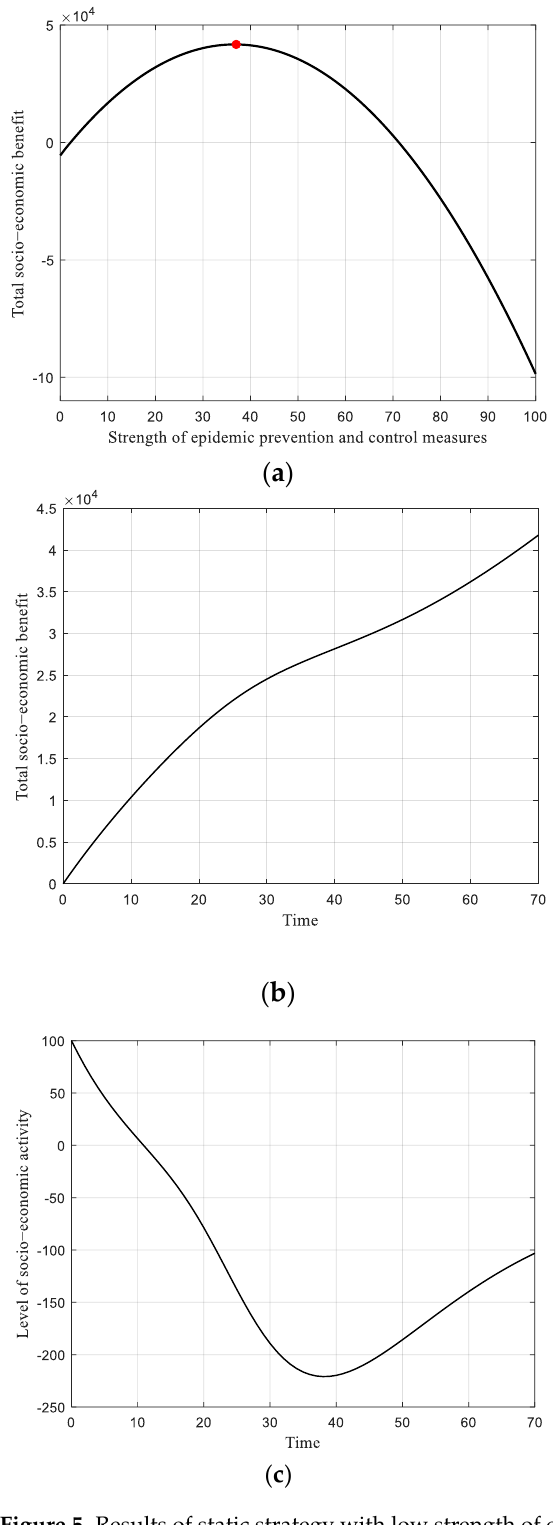
Figure 5. Results of static strategy with low strength of economic stimulus. ( a ) Total socio-economic benefit versus strength of pandemic prevention and control measures with a low investment in economic stimulus measures ( E s = 3). ( b ) Trajectory of the total socio-economic benefit, along with time ( E p = 37 and E s = 3). ( c ) Level of socio-economic activity, along with time ( E p = 37 and E s = 3).